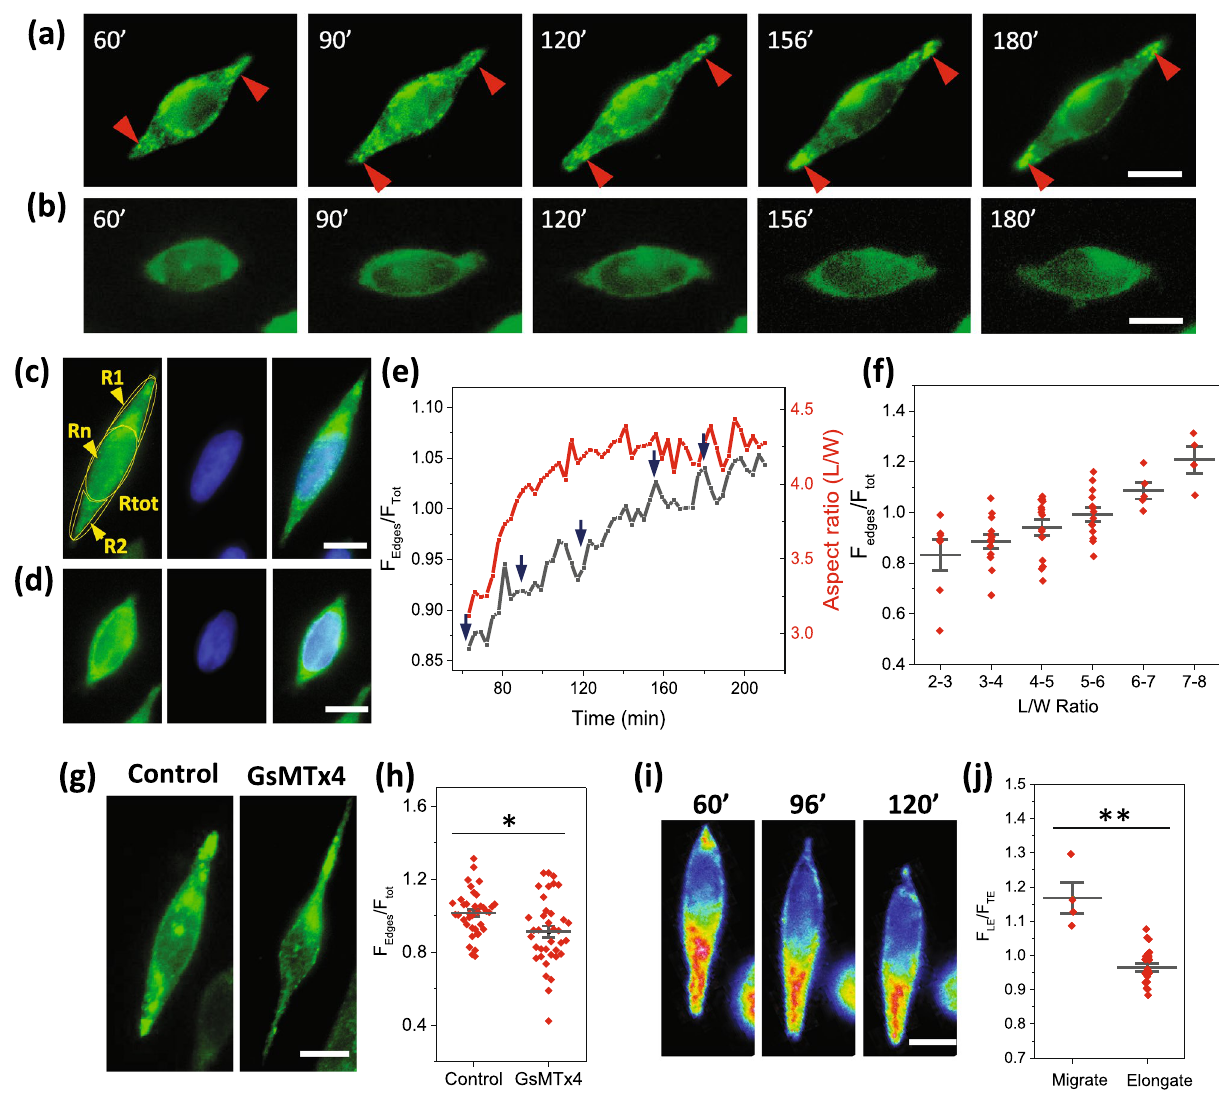
Figure 3. Redistribution of Piezo1 in HEK-hP1 cells on micropatterns. (a) Images of typical HEK-hP1 cell extending on the pattern from times indicated by blue arrows in (e) , showing Piezo1 plaques (indicated by red arrows) are present on the extrusion edges of an extending cell. (b) shows Piezo1 primarily distributed around the nuclear envelope in non-extending cells. The nucleus was stained using Hoechst 33342 dye for an extending (c) and a non-extending cell (d) . (e) Time course of average Piezo1 density over expansion edges (R1 and R2) normalized with whole cell (left axis) is compared with cell aspect ratio (right axis) of the cell in (a) , showing increased Piezo1 concentration is correlated with cell expansion. (f) Histogram of normalized Piezo1 density at the expansion edges of cells elongated to various aspect ratios, showing higher Piezo1 density corresponding to larger expansion (n = 7, 14, 15, 14, 5, 4, sequentially). (g) Fluorescence images show that Piezo1 clusters remained in the tails in the presence of GsMTx4. (h) Relative Piezo1 density in the tails following GsMTx4 is slightly lower compared with control cells (n = 37, p = 0.007, *p < 0.01). (i) Time sequence of Piezo1 distribution in a migrating cell shows a significantly higher Piezo1 density at the leading edge. (j) Comparison of Piezo1 density in the leading edge compared to the trailing edge between migrating and stably elongated cells (n = 25 for elongating cells, n = 4 for migrating cell, ** p < 0.001), from multiple experiments. Scale bars represent 10 edges (indicated by red arrows in Fig. 3a). In non-stretching cells, Piezo1 proteins were primarily located on the nuclear envelopes or in the middle of the cells (Fig. 3b). This is shown by staining the nucleus with Hoechst 33342 dye (Fig. 3c,d). Piezo1 density around nucleus (Fig. 3c, Rn), in expansions beyond the nucleus (Fig. 3c, R1 and R2), and the whole cell (Fig. 3c, Rtot) were measured, respectively, and the density in both expansions was averaged and normalized by the total density over the whole cell. The time course of the Piezo1 density at the edge and the corresponding body aspect ratio in Fig. 3a is shown in Fig. 3e. An increase in Piezo1 density in extrusion edges coincided with elongation. The mean Piezo1 density at extrusion edges for various cell aspect ratios is shown in Fig. 3f. The edge protein density was consistently higher in stretching than non-stretching cells. In cells treated with GsMTx4, Piezo1 clusters remained in the tails (Fig. 3g). The Piezo1 density in some